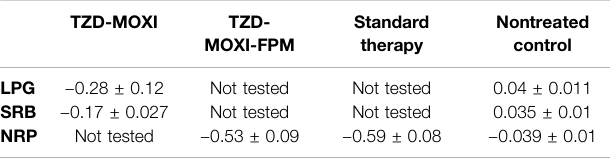
TABLE 1 | Growth rate of M. tuberculosis in nontreated HFS-TB and kill rate with experimental and standard regimen.